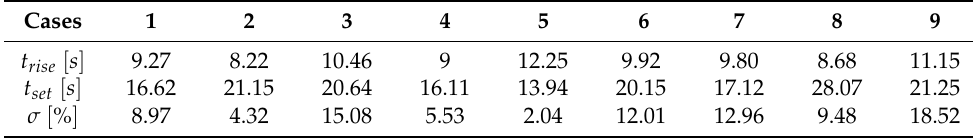
Figure 12. Transient responses of the closed-loop system. Angular velocity reference tracking: distributed ˙ ϕ ( z , t ) . Table 2. Performance measures for ˙ ϕ 0